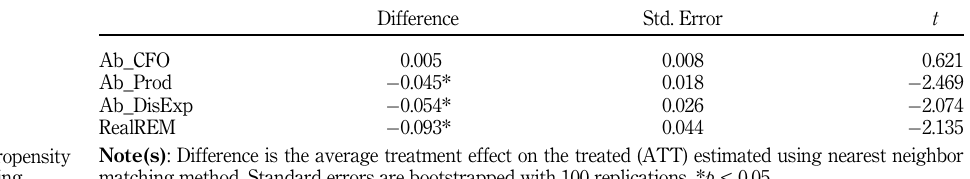
Table 5. Results of regression on RealREM